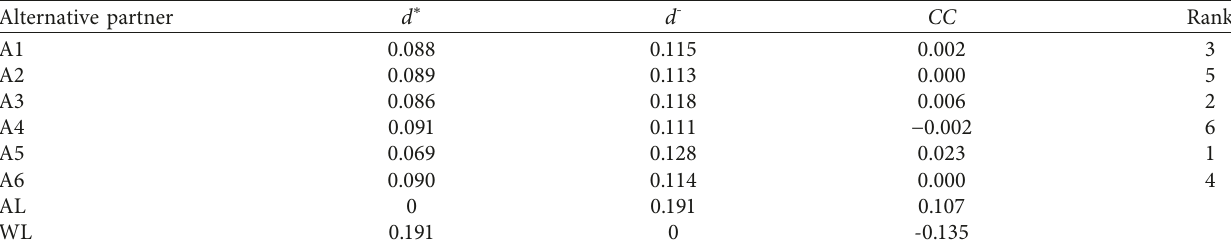
Table 15: The analysis results of the neutrosophic